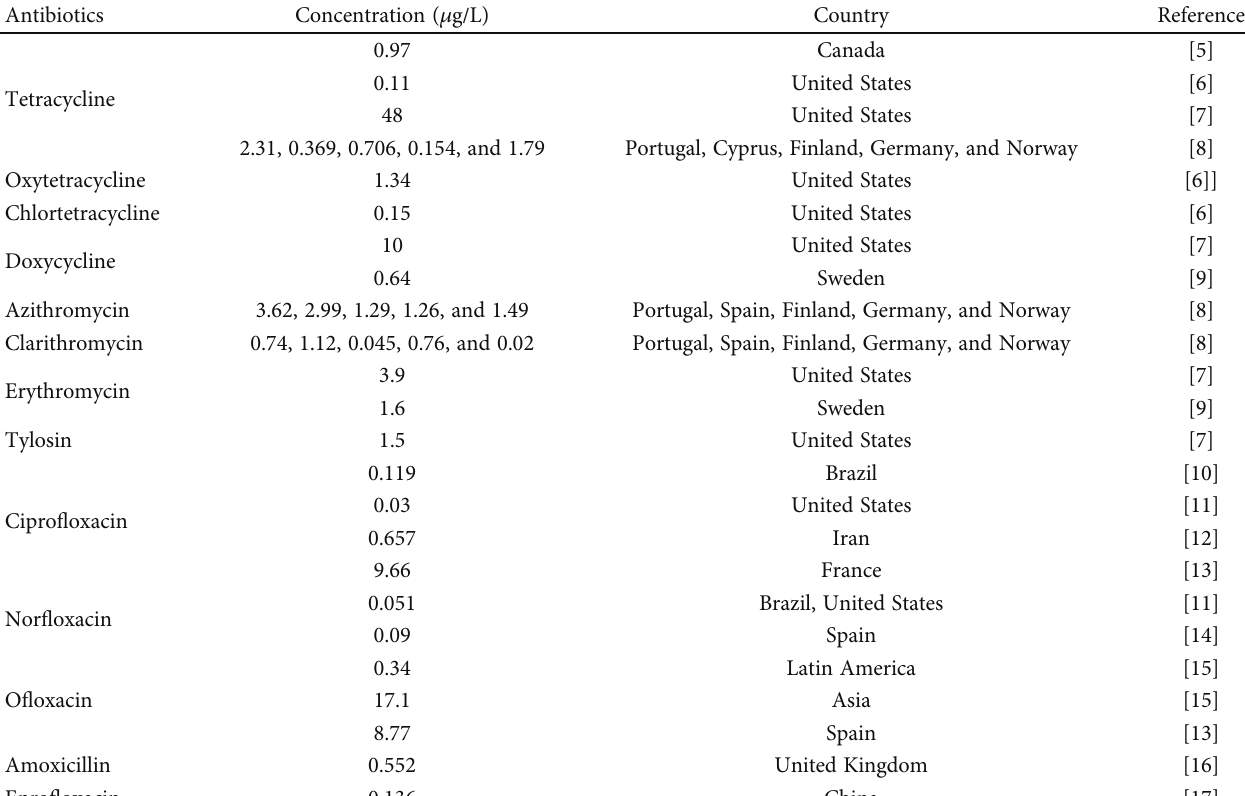
Table 1: Antibiotic residues detected in the aquatic environments of di ff erent